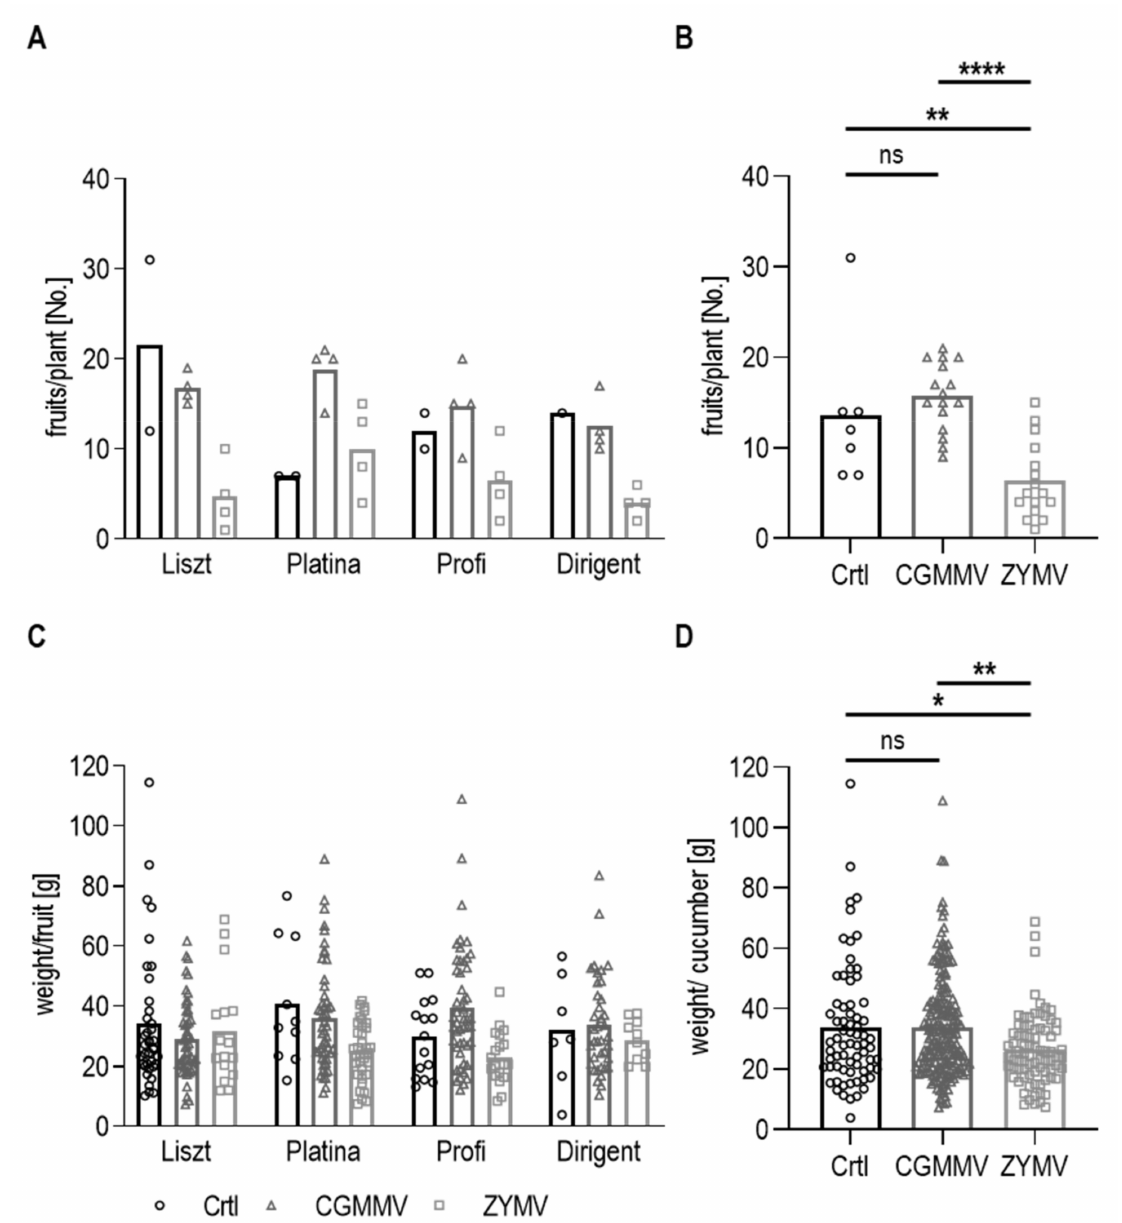
Figure 3. Yield per C . sativus plant (fruit/plant) and weight per fruit. The plants were infected with CGMMV or ZYMV and cultivated under greenhouse conditions. The impact of the viruses on the number of fruits per plant ( A , B ) and their weight ( C , D ) is independent of the cultivar. No significant differences between the cultivars (‘Liszt’, ‘Platina’, ‘Profi’, ‘Dirigent’) were found between the control plants. These viruses each have a significant influence on the number of fruits ( B ) and their weight ( D ) in general. The plant numbers per cultivar were n = 4 for infected plants per virus variant. The numbers of control plants per cultivar were n = 2 with the exception of cultivar ‘Dirigent’ with n = 1. The numbers of harvested fruits for control plants per cultivar were as follows: ‘Liszt’ n = 43, ‘Platina’ n = 14, ‘Profi’ n = 24 and ‘Dirigent’ n = 14 (cid:48) . The numbers of harvested fruits for CGMMV-infected plants per cultivar were as follows: ‘Liszt’ n = 67, ‘Platina’ n = 75, ‘Profi’ n = 59 and ‘Dirigent’ n = 50 (cid:48) . The numbers of harvested fruits for ZYMV-infected plants per cultivar were as follows: ’Liszt’ n = 19, ‘Platina’ n = 40, ‘Profi’ n = 26 and ‘Dirigent’ n = 16 (cid:48) . ANOVA was performed with ns p > 0.05, * p ≤ 0.05, ** p ≤ 0.01, **** p ≤